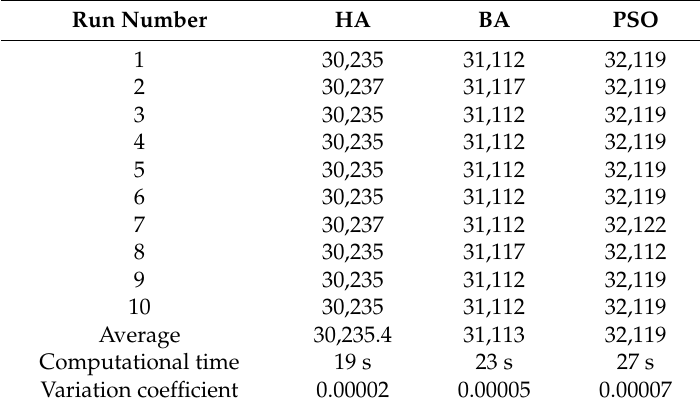
Table 13. Investigation of different methods for Karahan flood.